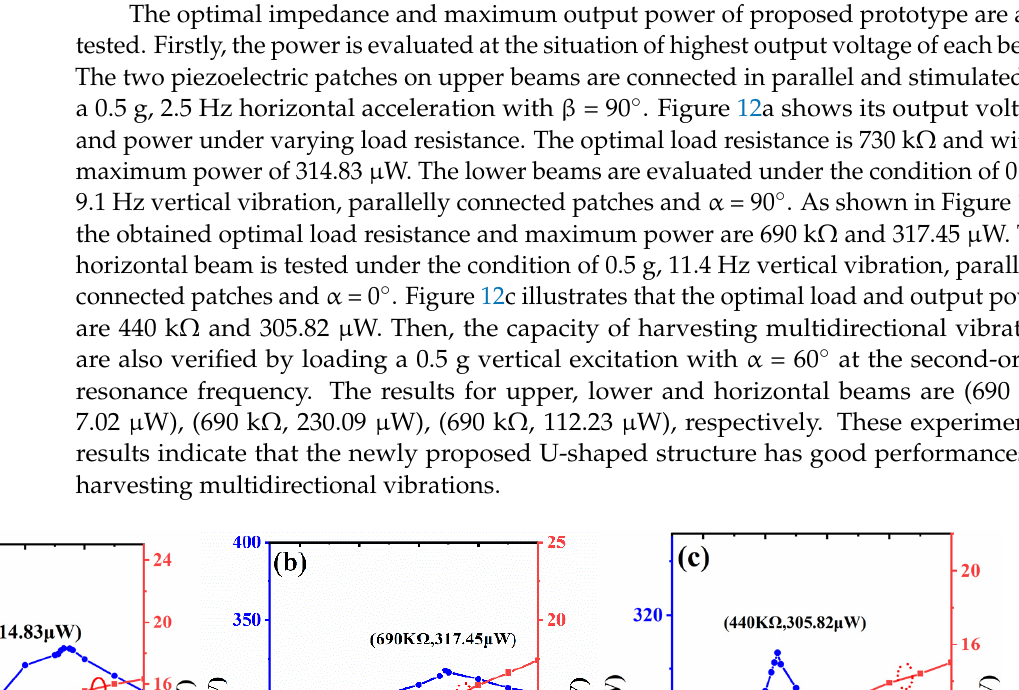
Figure 11. Output voltage of different beams versus β at the first three resonant frequencies: ( a ) upper beam, ( b ) horizontal beam, and ( c ) lower beam.